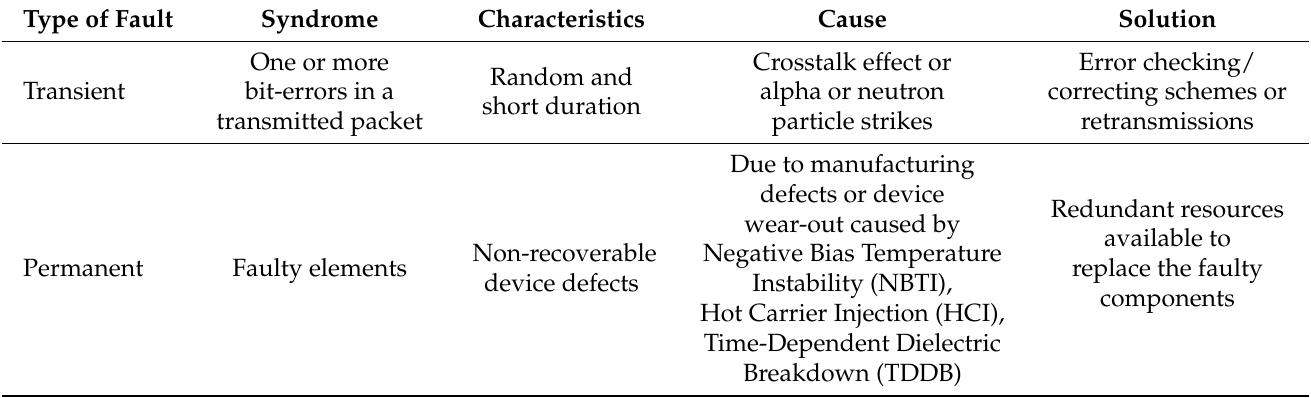
Table 3. Chip faults exhibit different syndromes and have various causes that affect NoC reliability [18,25–27]. Type of